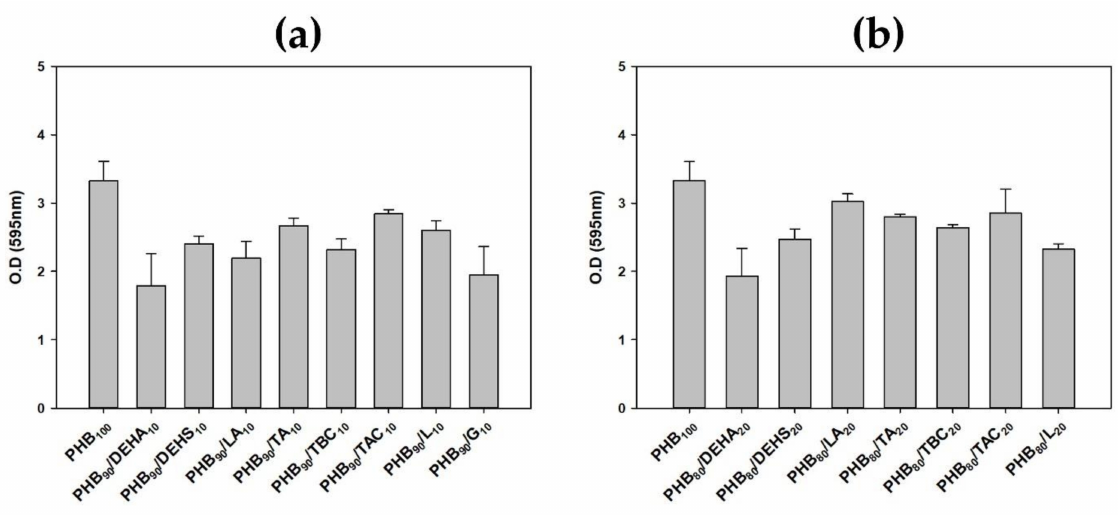
Figure 2. The growth pattern of Microbulbifer sp. SOL66 cultured with ( a ) 10% plasticized and ( b ) 20% plasticized PHB films.